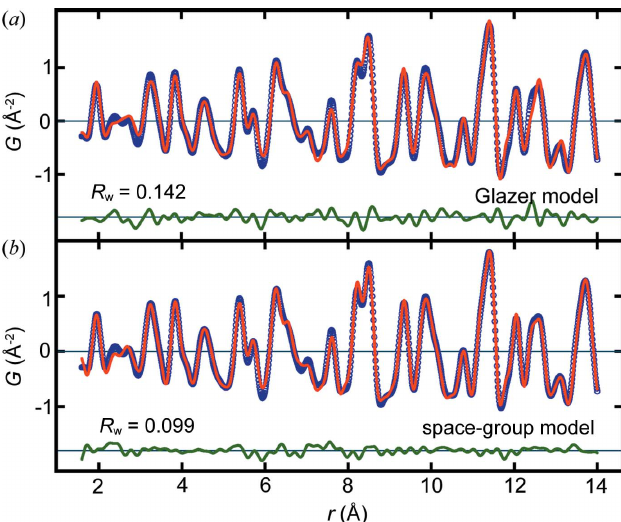
Figure 5 Plots of measured (blue) and best-fit (red) PDFs of CaTiO 3 with the difference curve plotted in green offset below over the r range 1.6–14 A˚ . The model for the best-fit PDF is from ( a ) the constrained Glazer tilt model in Glazer system 10 and ( b ) allowing all the structural degrees of freedom of the Pnma space-group model.